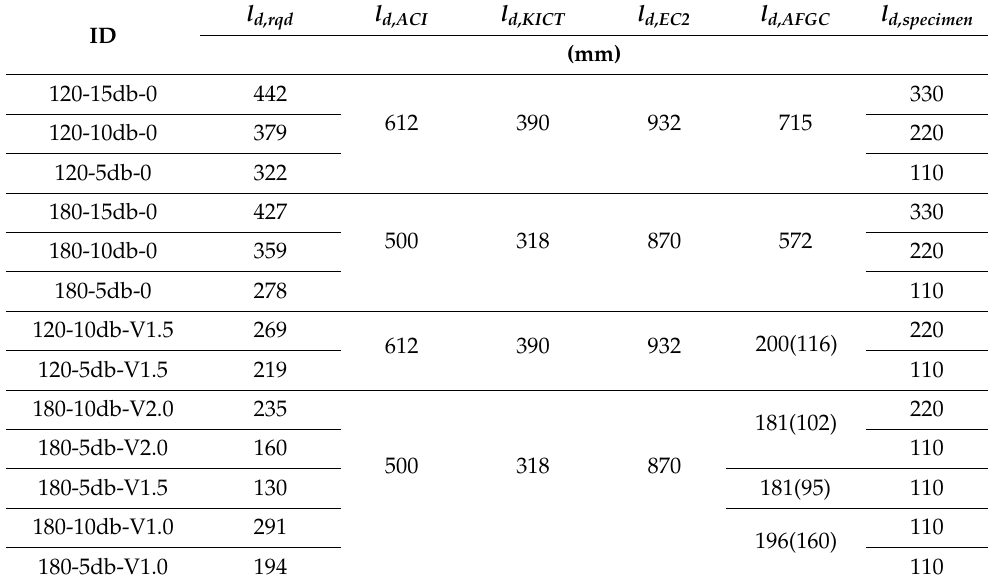
Table 6. Required lap splice